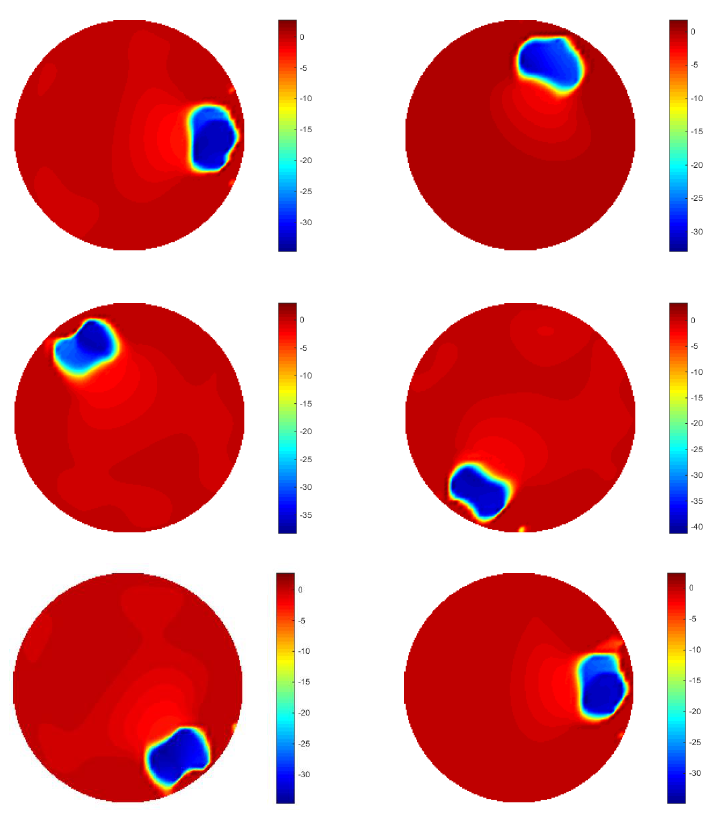
Figure 6. Image reconstruction of 2D experiment using temporal TV: a dynamic image generated in the experiment test, and images displayed here are extracted randomly to show the movement of the sample.